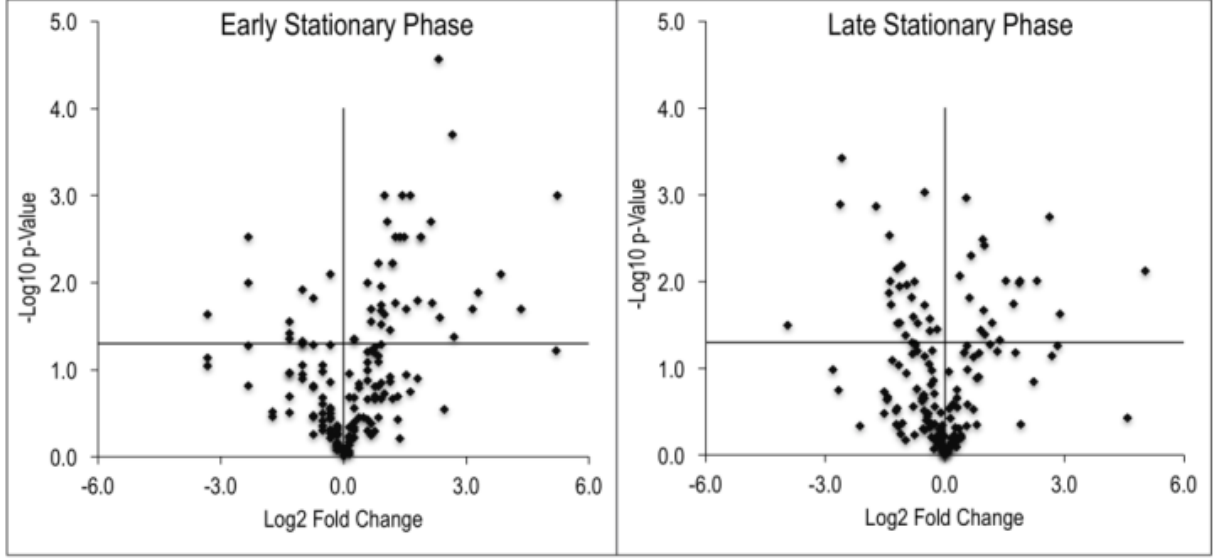
FIGURE 3: The metabolome of a purH mutant is significantly altered. Untargeted metabolomics was performed on wild-type and purH mutant of S. enterica grown in glucose minimal medium supplemented with adenine and thiamine. Relative concentrations of metabolites were determined by calculating the ratio of the average MS ion intensities (peak areas) in wild-type and purH strains ( purH /WT). Here the log transformed fold changes (Log2) and p-values (-Log10) were plotted against each other, distributing the metabolite pool decreases and increases to the left and right of the x=0 point, respectively. The horizontal line (y=1.3) indicates the threshold above which p-values were considered statistically significant (<0.05). These data are derived from one representative experiment (Table